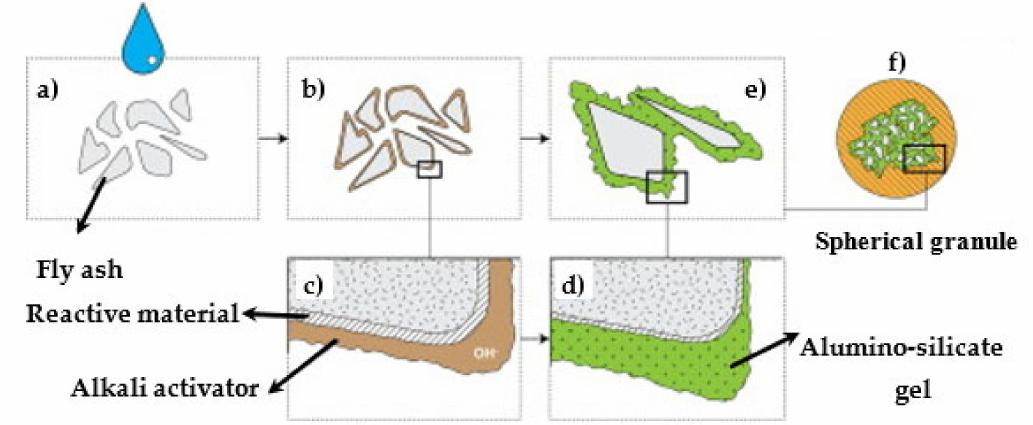
Figure 12. Descriptive prototypical of the granulation-alkali activation technique; ( a ) the precursor particles, ( b ) granulation process, ( c ) Materials reactions, ( d ) aluminosilicate gel, and ( e ) binding of particles. ( f ) Finally, the process produces spherical granules [187]. Reprinted with Permission from Elsevier